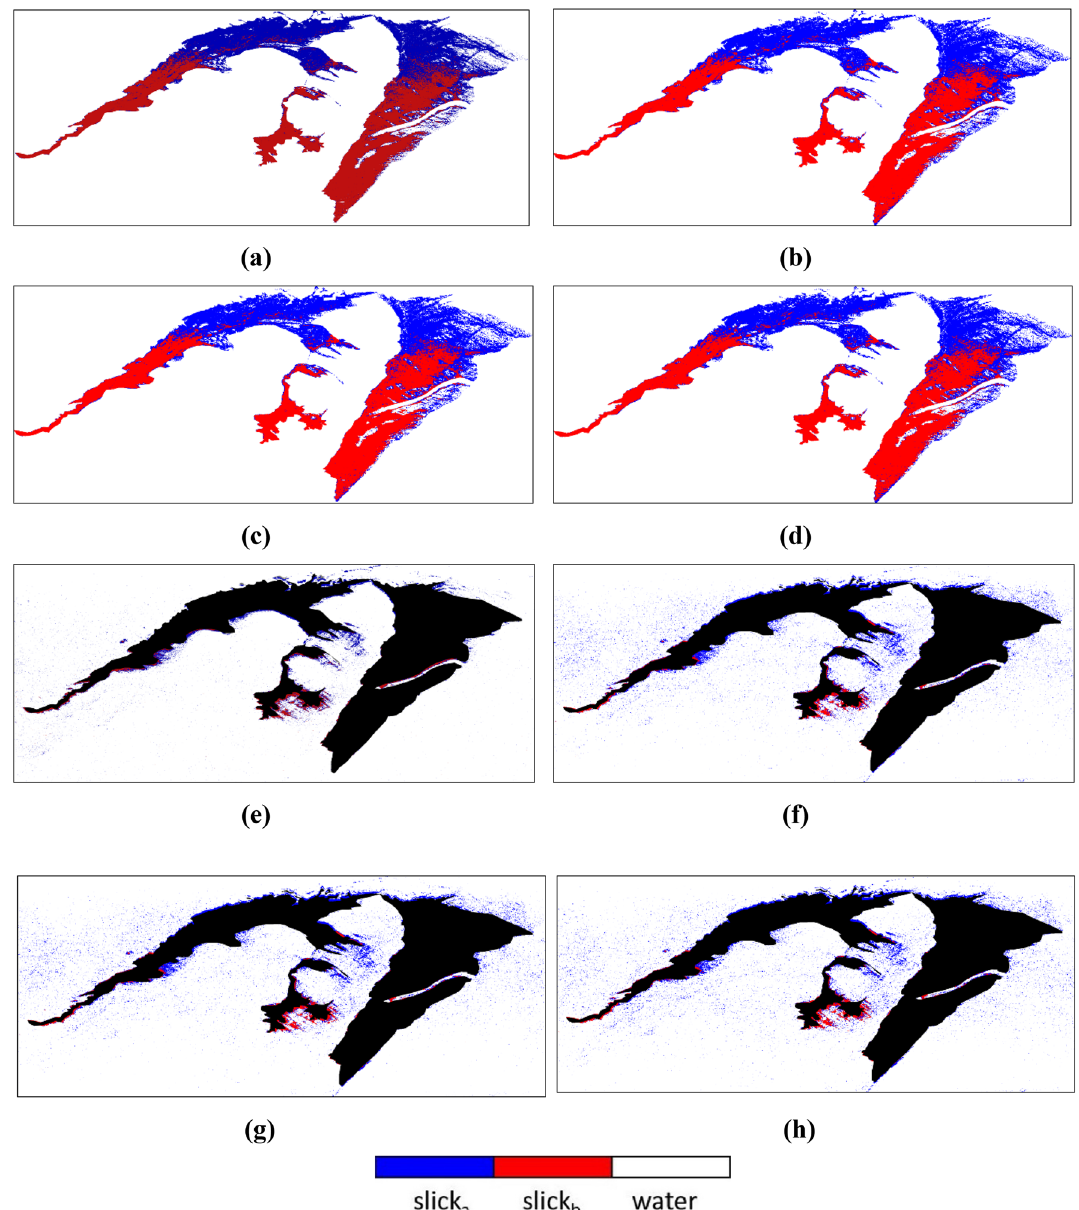
Figure 11. Oil spill subset from ( a – d ), and sea region subset from ( e – h ) for parameters λ3, Shannon Entropy, Coherency Matrix and, VV damping ratio